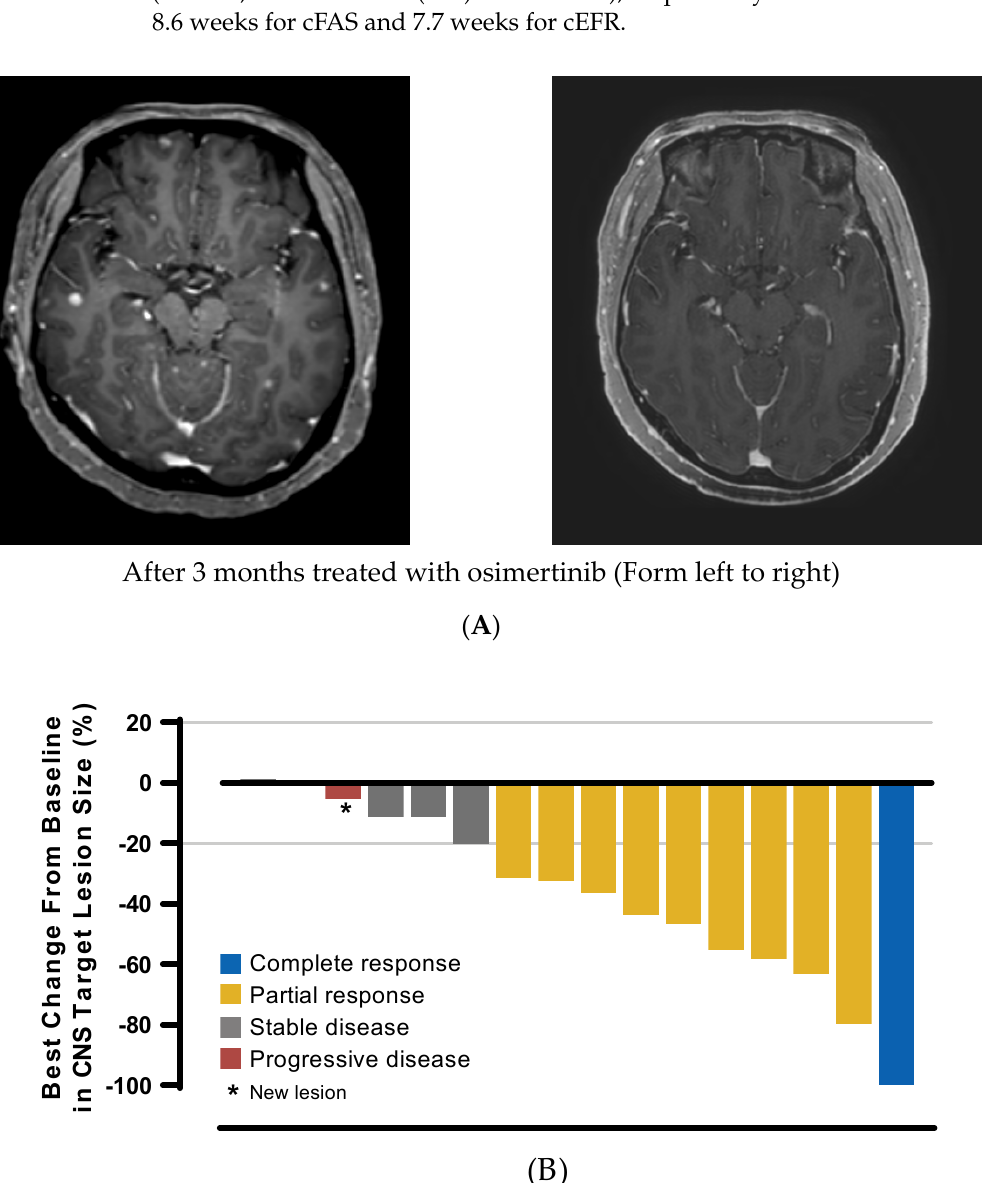
Abbreviation: cFAS, CNS full analysis set. * Patients with non-measurable disease only are in-